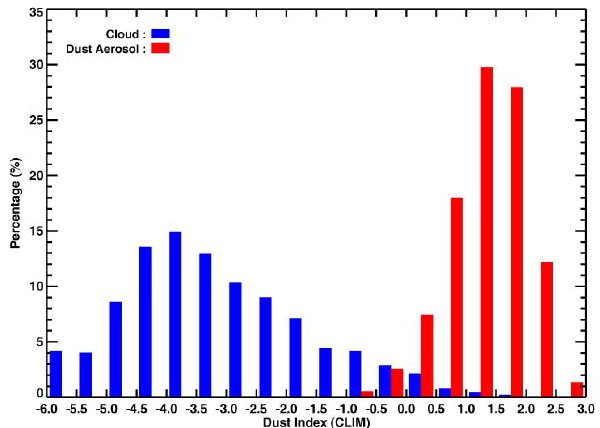
Fig. 8. Table 2 selection of cloud (blue) and dust aerosol (red) vs. CLIM method dust index for spring 2008.